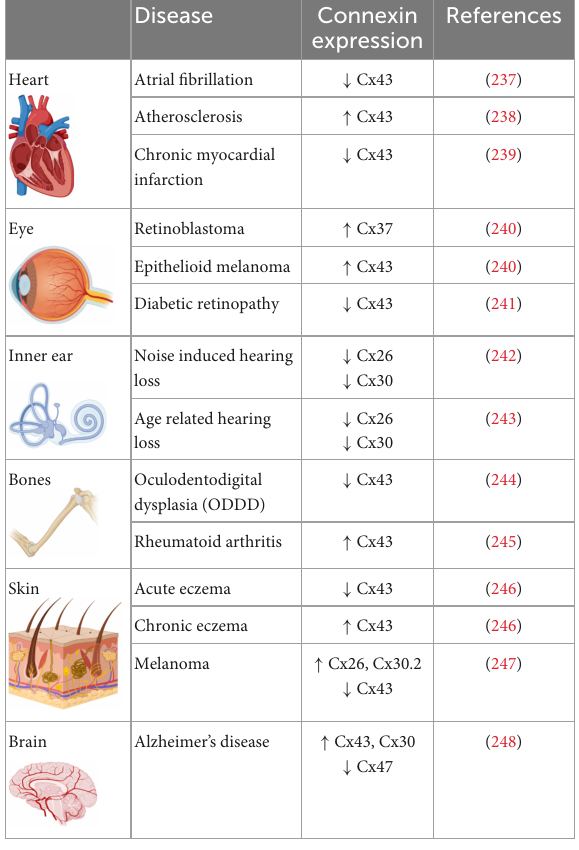
TABLE 1 Prevalence of connexin isoforms in various organs and their expression levels in diseases associated with the organs.